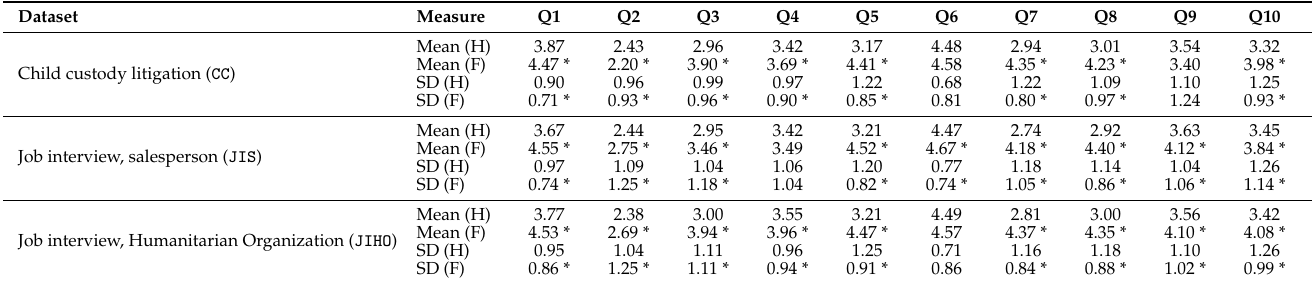
Table 2. Mean and standard deviation (SD) of the questions in each honest (H) and faked (F) questionnaire in different datasets. Values marked with a * indicate a statistically significant difference of the faked responses—Student’s t -test with p -value < 0.05—with the honest responses distribution to the same question. Different faking patterns emerge from different situations. For example, Q2 was changed in one direction in CC and in the opposite direction in JIS and JIHO . Average scores to the 10 questions do not differ significantly in the three groups of honest (H)